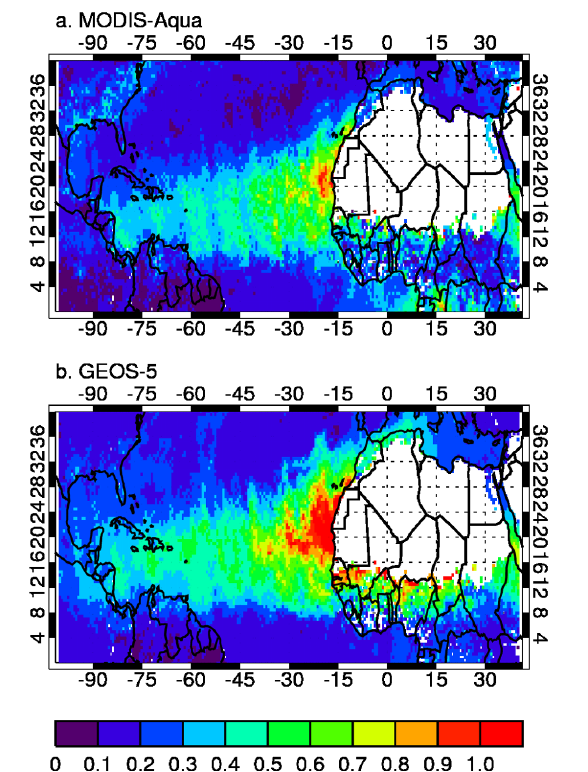
Fig. 3. MODIS-Aqua (a) and GEOS-5 sampled (b) July 2007 AOT.